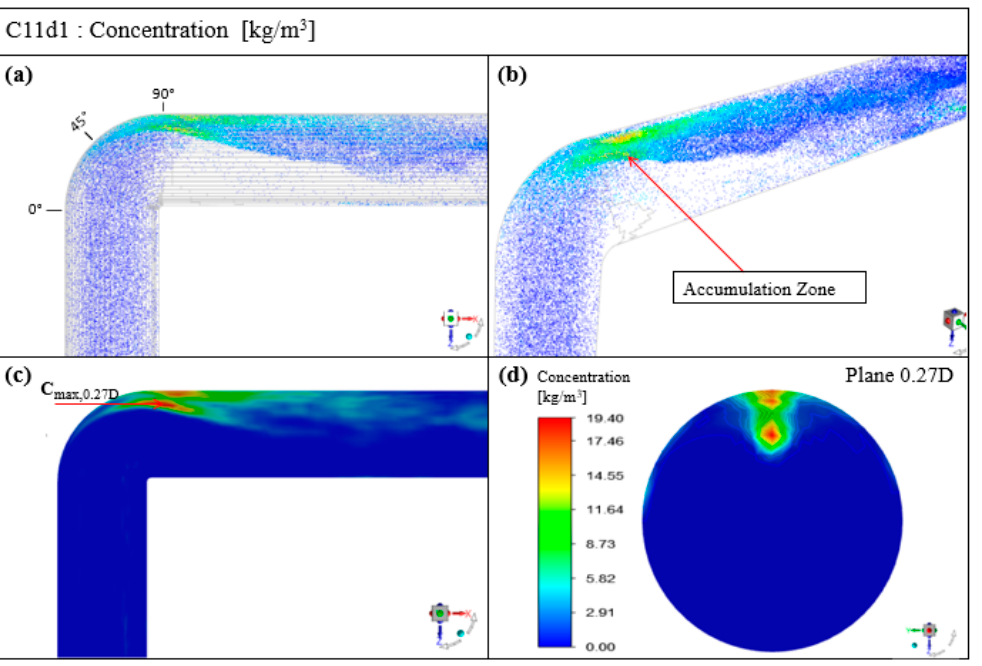
Figure A1. Results of particle concentration. Case C11d1. ( a ) Instant positioning of the X-Z plane particles ( b ) Instant positioning of the particles in 3D view ( c ) Concentration contour in the X-Z plane of the mid-section of the pipe ( d ) Concentration contour in the Z-Y plane of the maximum concentration cross section. Snapshots are taken for a statistically steady flow.